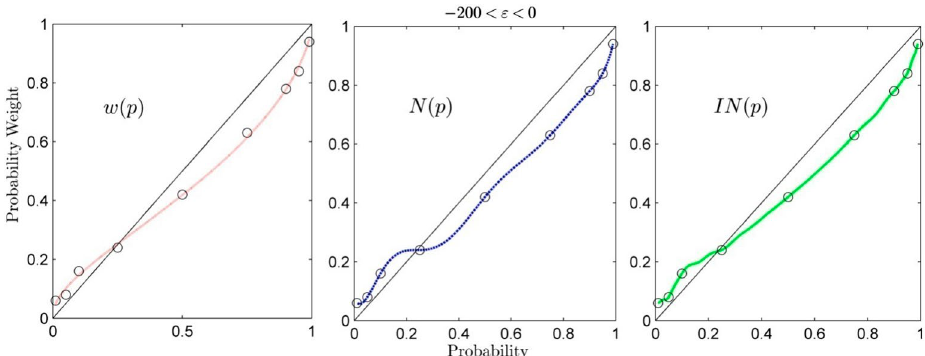
Figure 7. Curves of PWF based on w ( p ) , N ( p ) and nonparametric numerical model IN ( p